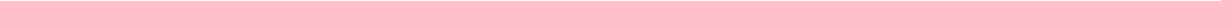
Fig. 4 Molecular pro fi ling of RTs from P0-CreC;Smarcb1 fl ox/ fl ox mice. a Unsupervised hierarchical clustering of gene expression pro fi les from 12 P0-CreC; Smarcb1 fl ox/ fl ox mouse tumors and 49 human AT/RTs 43 using the 5,000 most variable transcripts. The P0-CreC;Smarcb1 fl ox/ fl ox tumors distributed among the three human AT/RT molecular subgroups. Information about tumor molecular subgroups and anatomical location is displayed in the lower bars. b Unsupervised hierarchical clustering of gene expression pro fi les from 12 P0-CreC;Smarcb1 fl ox/ fl ox mouse tumors, eight tumors from the tamoxifen inducible Rosa26-Cre ERT2 ;Smarcb1 fl ox/ fl ox mouse model 30 and fi ve tumors from the hGFAP-Cre;Smarcb1 fl ox/ fl ox ;Trp53 fl ox/ fl ox mouse model 44 using the 5,000 most differentially expressed genes. Information about tumor molecular subgroups is displayed in the lower bars. c Normalized expression level of representative genes for both of the three human AT/RT molecular subgroups: hTYR ( n = 16), hSHH ( n = 16), and hMYC ( n = 17) and the three P0-CreC; Smarcb1 fl ox/ fl ox RT molecular subgroups: mRT-Tyr ( n = 5), mRT-Shh ( n = 4) and mRT-Myc ( n = 3). On the basis of the cluster analysis in ( a ), we respectively named hMYC, hSHH and hTYR the three tumor subgroups including human tumors from the MYC, SHH and TYR molecular subgroups 43 . The P -value indicates the statistical signi fi cance of gene enrichment within their respective WGCNA module for each respective molecular subgroup. d – g Gene expression levels of speci fi c SWI/SNF complex subunits ( d , e ) and NC developmental markers ( f , g ) in the three molecular subgroups of P0- CreC;Smarcb1 fl ox/ fl ox RTs ( d , f ) and human AT/RTs ( e , g ). d , f RNA-Seq data are expressed in RPKM (Reads Per Kilobase of transcript per Million mapped reads). e , g graphs of microarray gene-expression intensity from dataset GSE70678. c – g RNA-Seq and microarray gene expression levels are shown using Tukey boxplots: the central lines represent the median, boxes (interquartile range or IQR) represent 50% of data ranging from the 25 to 75% quantile, whiskers represent extremes up to 1.5-fold box size, circles show